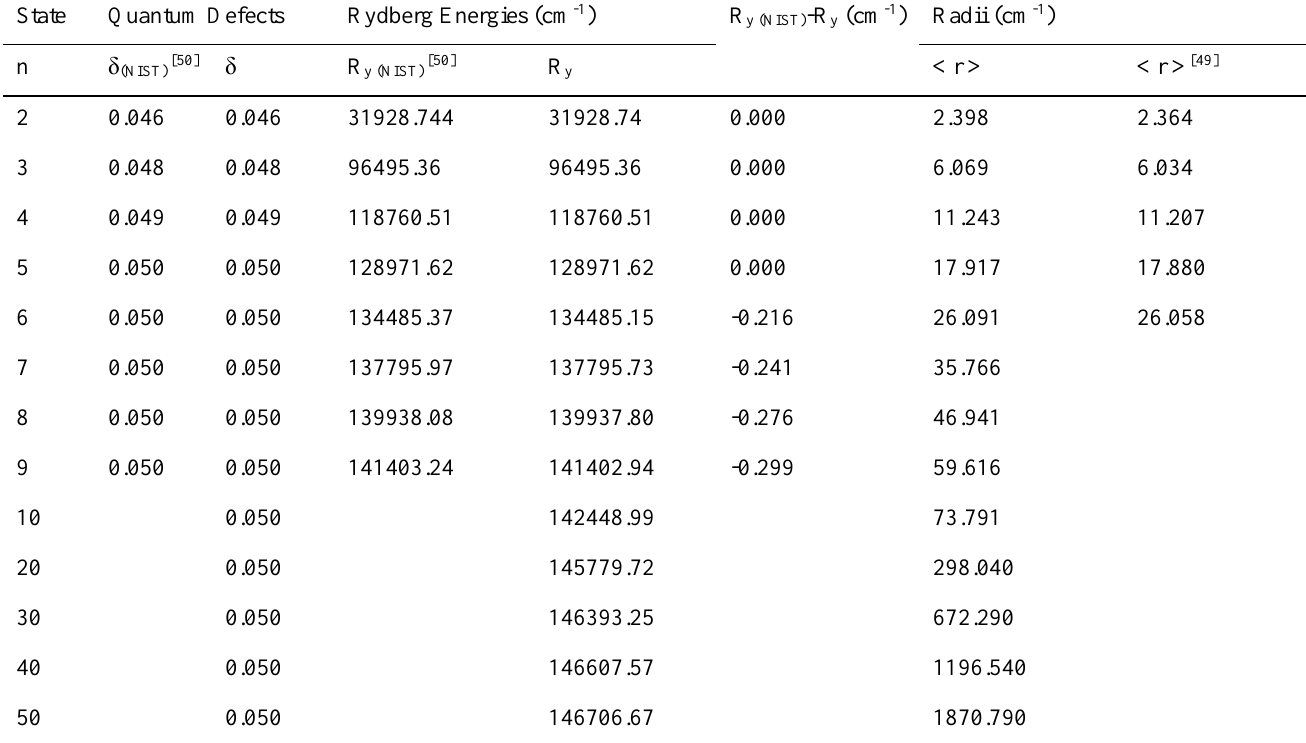
Spectral Rydberg Energy Series with Quantum Defects and Radii of Li iso-electronic sequence in 1 s 2 np 2 P o 1/2 (Be II)